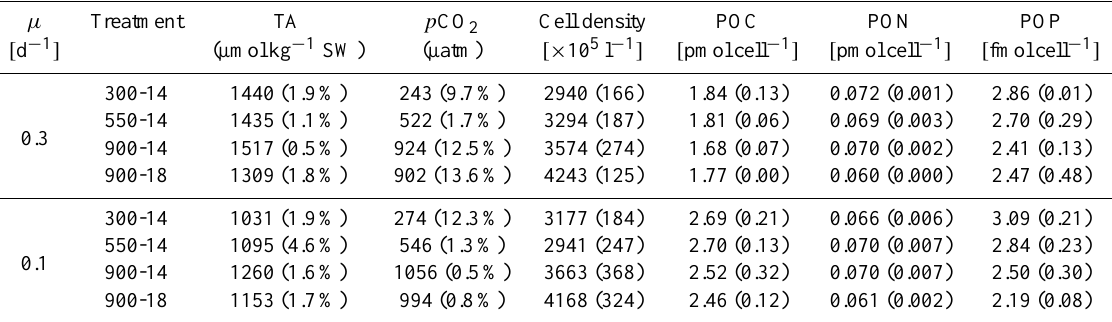
Table 1. Total alkalinity (TA), partial pressure of CO 2 ( p CO 2 ) , cell densities and cell quota for particulate organic carbon (POC), nitrogen (PON) and phosphorus (POP). Mean values and standard deviations (in parentheses, for TA and p CO 2 as %) were derived from sampling 1, 2 and 3 ( µ = 0 . 3d − 1 ) and from sampling 4, 5 and 6 ( µ = 0 . 1d − 1 ) , respectively. µ Treatment TA p CO 2 Cell density POC PON POP [ d − 1 ] (µmolkg − 1 SW) (µatm) [× 10 5 l − 1 ] [ pmolcell − 1 ] [ pmolcell − 1 ] [ fmolcell − 1 ] 300-14 1440 (1.9%) 243 (9.7%) 2940 0.3